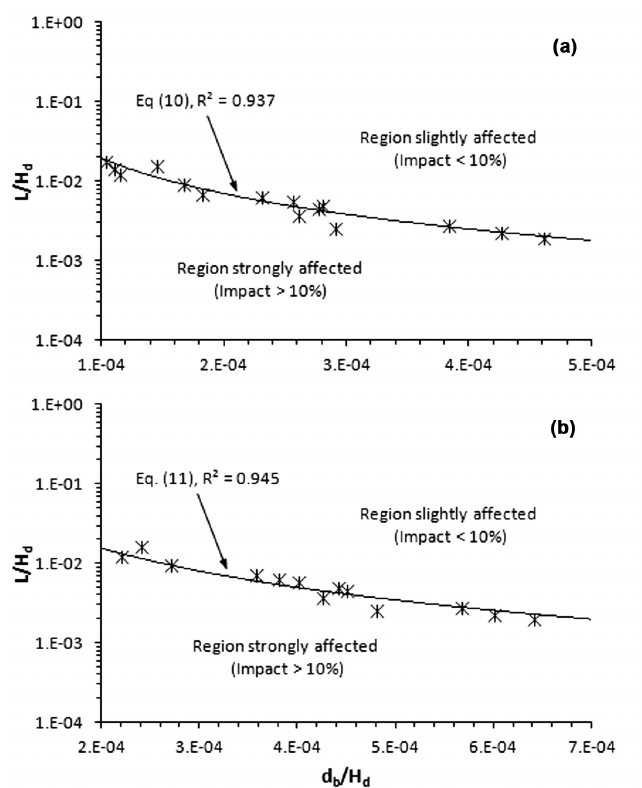
Figure 7 - Dimensionless correlations to predict the impact of mass transfer on bubble plume hydrodynamics for (a) aeration and (b) oxygenation systems. Stars represent model simulations for different values of d /H and L/H that resulted in a maximum deviation of u of b d d c 10%, as compared to the reference case of no bubble dissolution. The ( ) 152 parameter L is a length scale given by L Q g = and R² is the , g a coef fi cient of